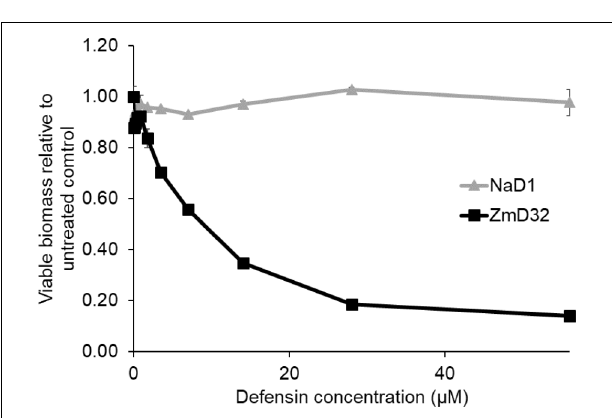
FIGURE 3 | Activity of ZmD32 against C. albicans biofilms. C. albicans biofilms were established for 24 h and washed to remove planktonic cells before incubation with a range of concentrations of ZmD32 or NaD1 for 24 h in RPMI. Viable cells were detected using Presto Blue. Viability was calculated as absorbance at 570 nm (Presto Blue) normalized to absorbance at 600 nm relative to the untreated control. ZmD32 eliminated viable cells in a C. albicans biofilm in a concentration dependent manner whereas NaD1 had no activity. Data is representative of three independent experiments. Error bars are standard error of three